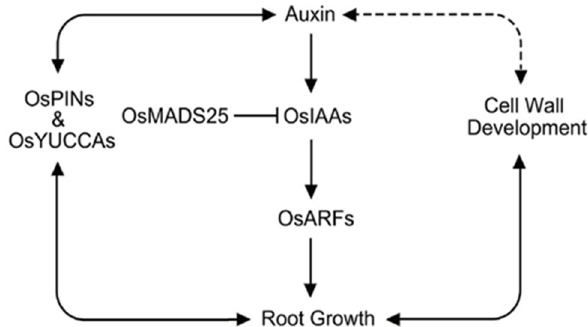
Figure 3. A schematic of auxin-mediated root growth in rice. Auxin response regulates root growth in rice, and the auxin response is controlled by auxin-related genes such as OsYUCCAs for auxin biosynthesis, OsPINs for transport, and OsARFs for signaling. OsMADS25 is not a direct component of the auxin signaling pathway, but regulates root growth by controlling the expression of OsIAAs . Cell wall development also regulates root growth in rice, and it is likely that auxin is involved in this process. Dashed arrow indicates hypothetical regulation.